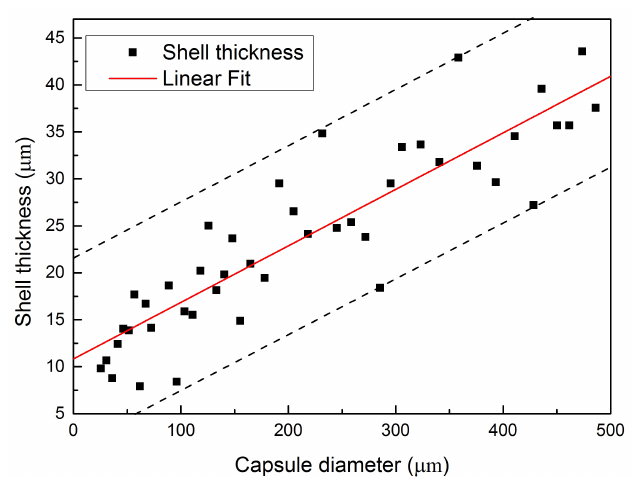
Figure 6. Relationship between the diameter and shell thickness of microcapsules.